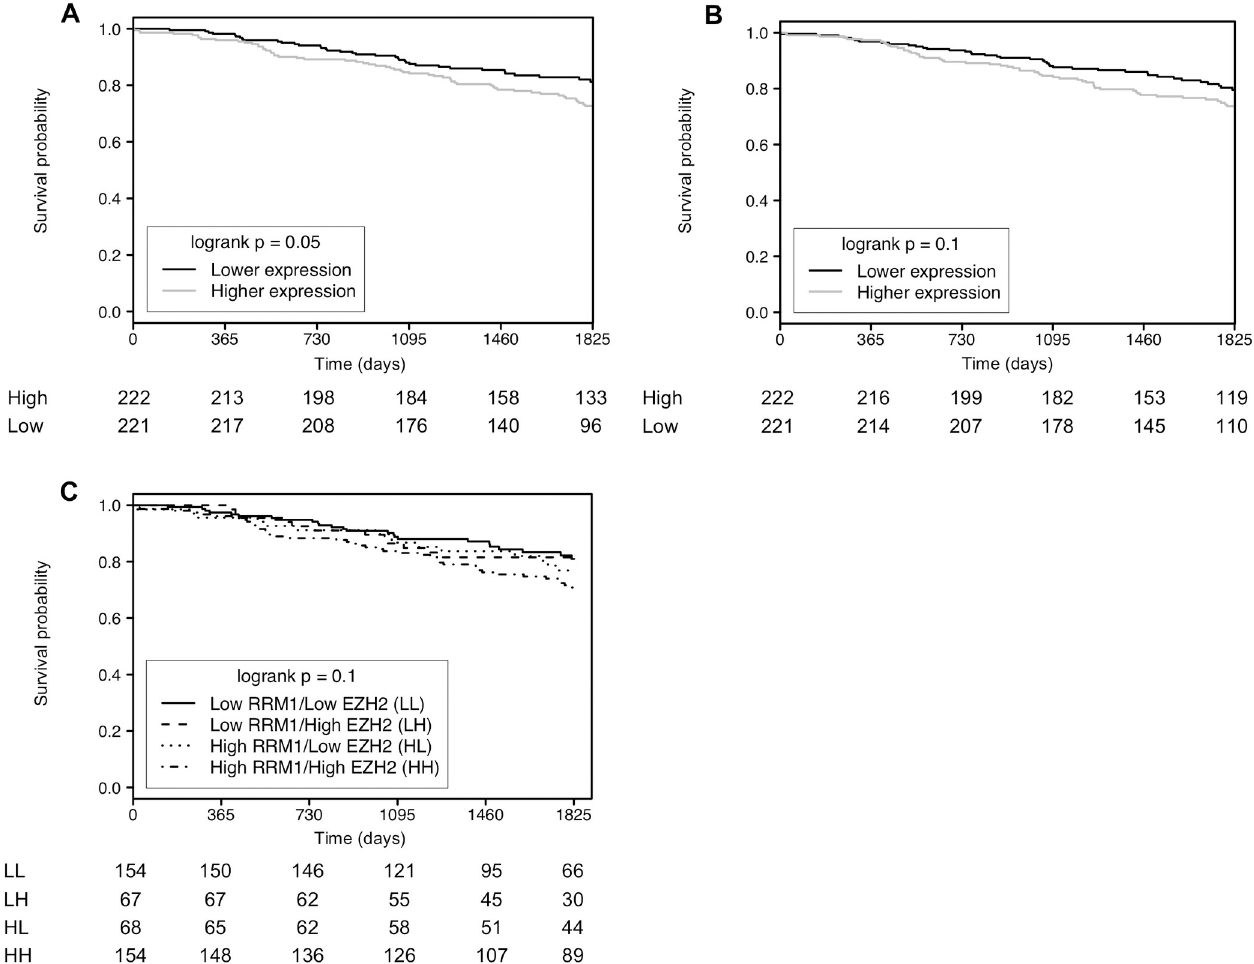
Fig 4. Kaplan-Meier analysis of overall survival in the combined set according to median-derived risk categories for RRM1 (A), EZH2 (B) and combination of RRM1 and EZH2 (C).